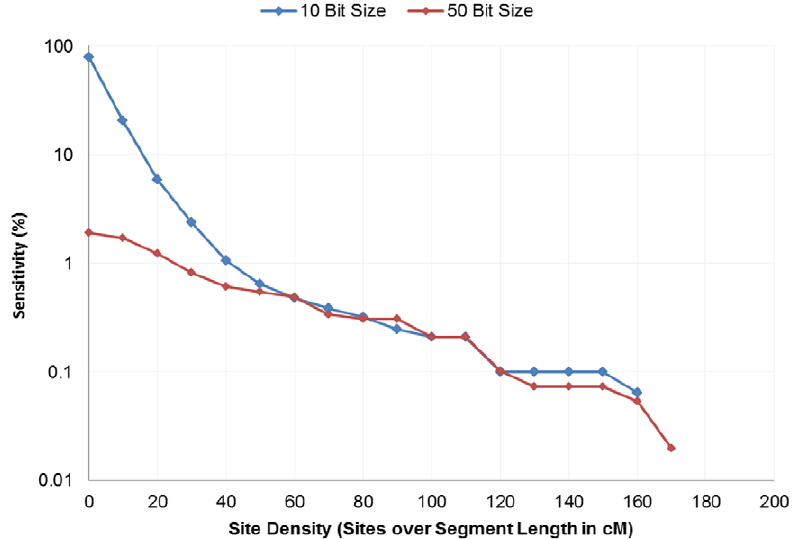
Figure 4. Exome sensitivity with varying exome site density. We see a decrease in sensitivity of exome generated IBD segments in their ability to cover the segments discovered from GWAS IBD as we increase the threshold of site